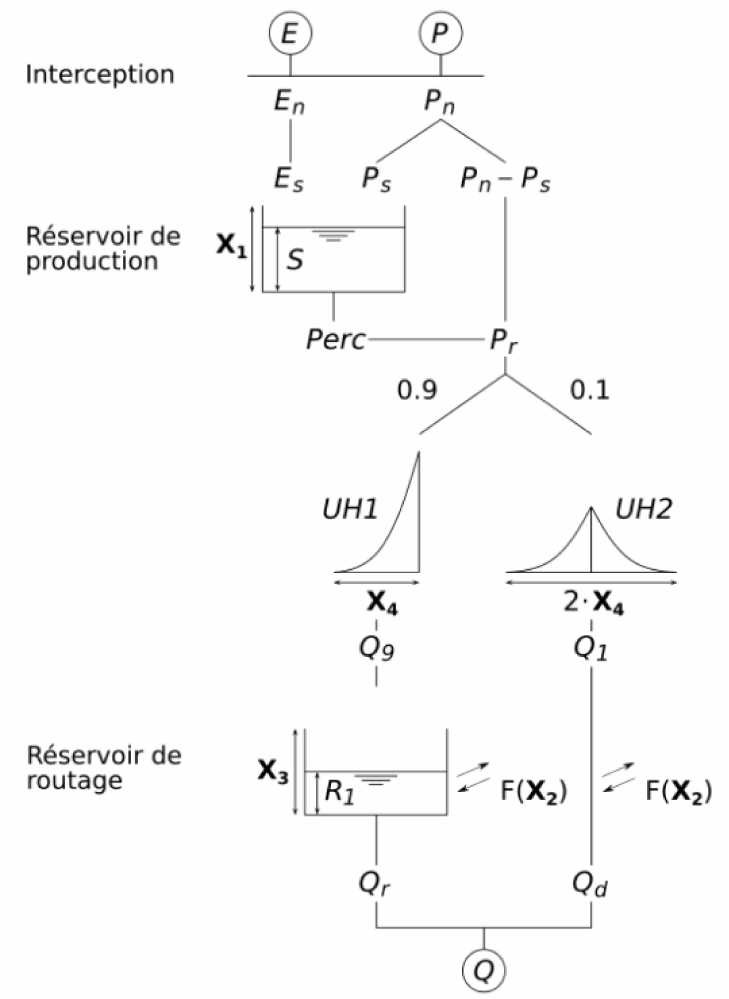
Figure 4. Schematic representation of the 4-parameter model GR4J